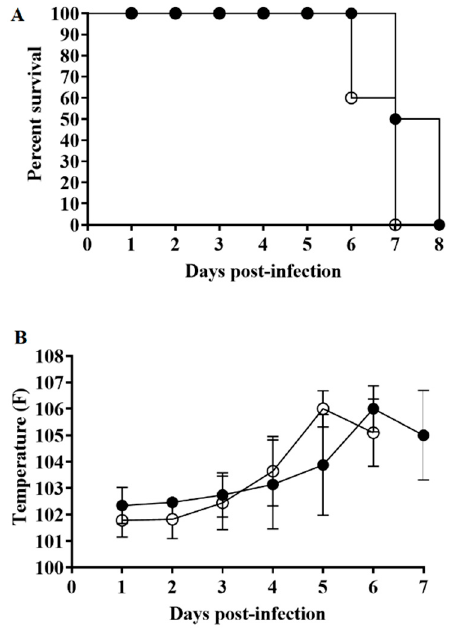
Figure 5. Evolution of mortality ( A ) and body temperature ( B ) in animals (5 animals / group) Intramuscular (IM) infected with 10 2 HAD 50 of either ASFV-G- ∆ C962R (filled symbols) or parental ASFV-G (open symbols). No significant differences in rectal temperatures between both groups of pigs were found at any sample time tested using the Holm–Sidak method ( α = 0.05) without assuming a consistent standard deviation. All calculations were conducted using the software GraphPad Prism version 8.